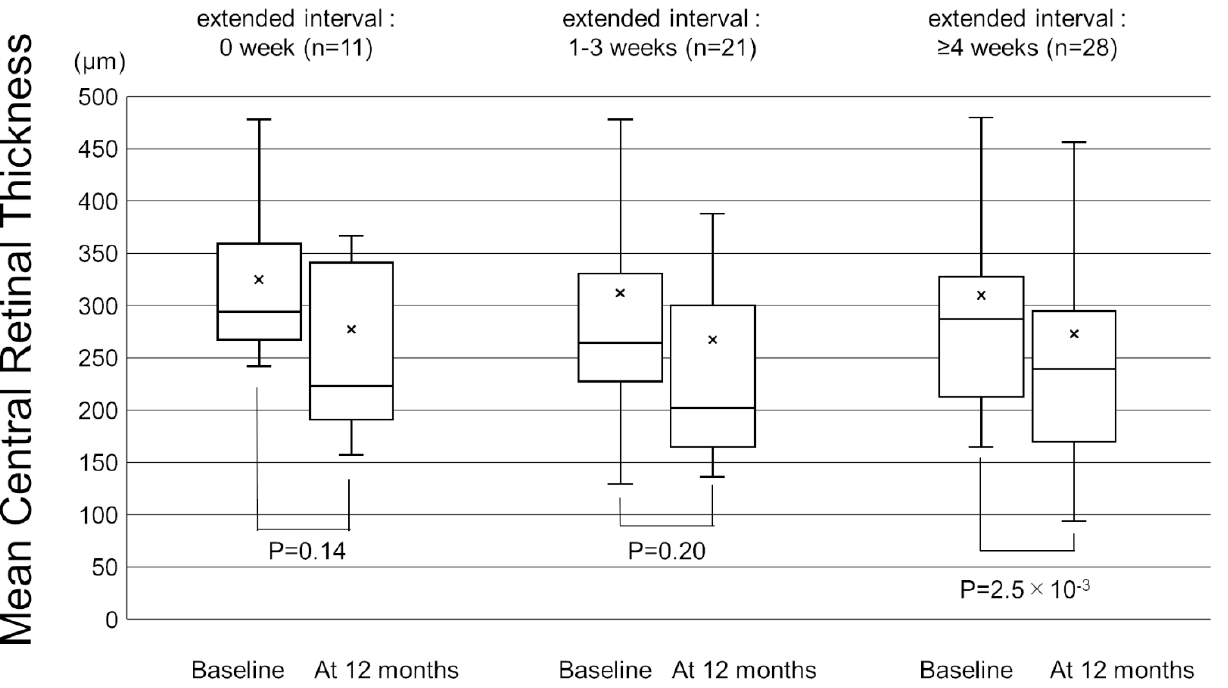
Figure 4. Box-and-whisker plot of mean and median central retinal thickness (CRT) on swept-source optical coherence tomography (SS-OCT) before and after switching to brolucizumab according to the extended treatment intervals. The “x” marks in the boxes indicate the mean CRT. The horizontal lines in the boxes indicate the median CRT, and the top/bottom edges of the boxes indicate the 25/75 percentile. The top/bottom edges of the whiskers indicate maximum/minimum values. ( Left ) The mean change of CRT in the patients with extended intervals of 0 weeks. ( Middle ) The mean change of CRT in the patients with extended intervals of 1–3 weeks. ( Right ) The mean CRT significantly decreased from baseline to 12 months in the patients with extended interval of ≥ 4 weeks.